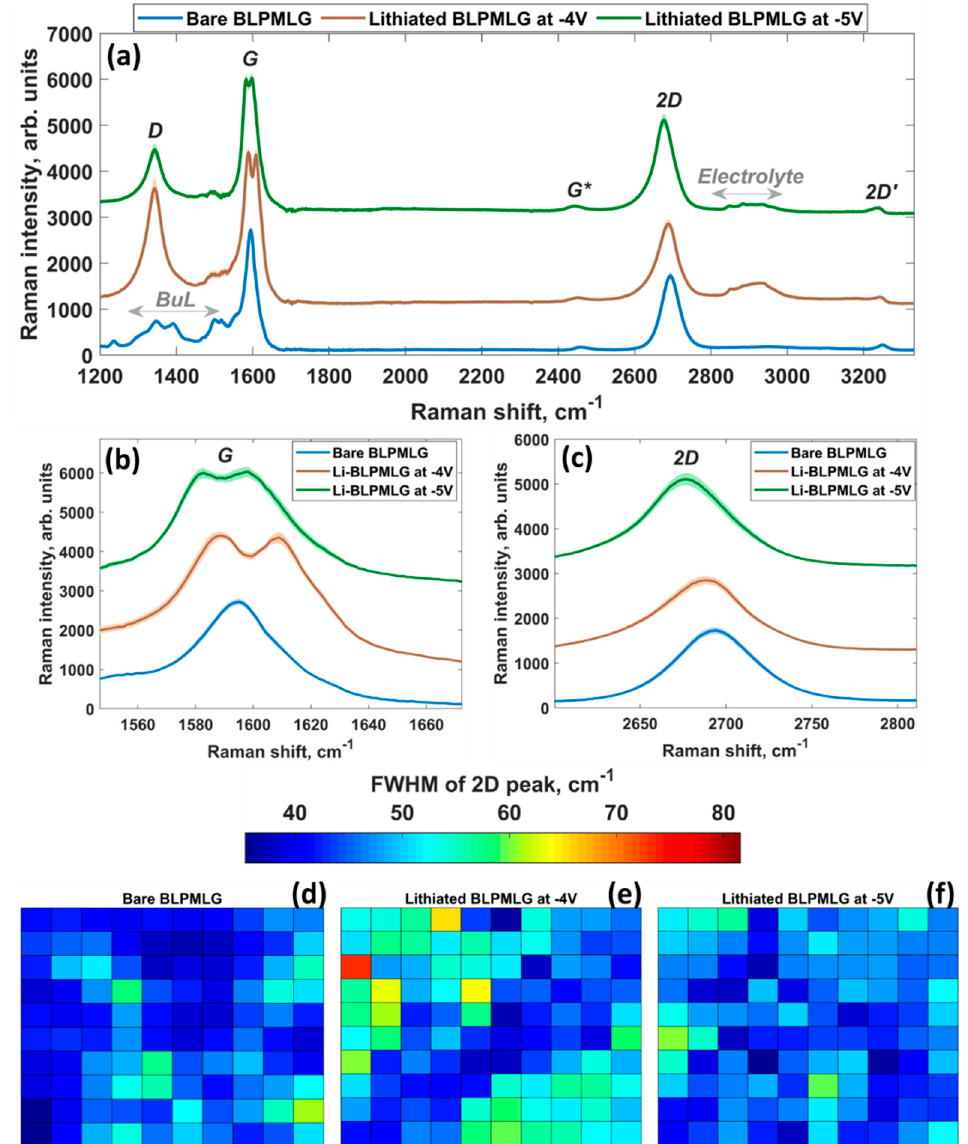
Figure 7. ( a ) Raman spectra of the BLPMLG/SiC electrode before and after lithiation. ( b,c ) Zoomed G and 2 D peak spectral regions for pristine and lithium-intercalated samples, respectively. Maps of FWHM values of 2 D peak for ( d ) bare BLPMLG/SiC electrode and for electrodes lithiated at ( e ) − 4 V and ( f ) − 5 V. Each colored box represents one Raman spectrum. 121 Raman spectra per map were analyzed to construct the maps.